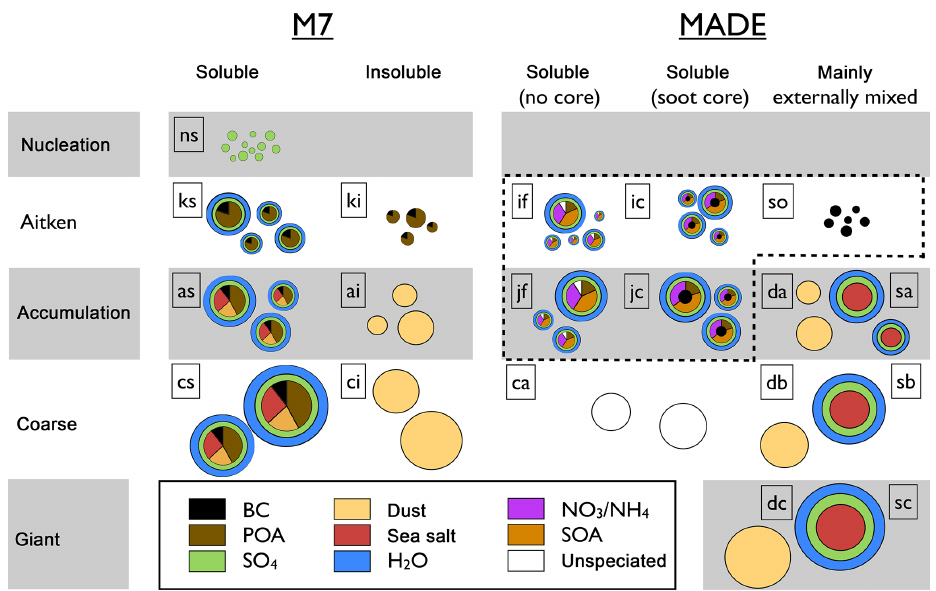
Figure 1. Comparison of chemical composition of aerosol modes for MADE and M7. The dashed line indicates modes that are considered for inter- and intra-modal coagulation in MADE. For M7, all modes participate in coagulation or intra-modal transfer by coagulation. The size and standard deviation of modes can be determined from Table 1 based on the two-letter abbreviations stated at the upper left of each mode (ns: M7 nucleation mode; ks: M7 solute-containing Aitken mode; ki: M7 insoluble Aitken mode; as: M7 solute-containing accumulation mode; ai: M7 insoluble accumulation mode; cs: M7 solute-containing coarse mode; ci: M7 insoluble coarse mode; if: MADE soluble Aitken mode without soot core; ic: MADE soluble Aitken mode with soot core; so: MADE pure soot mode; jf: MADE soluble accumulation mode without soot core; jc: MADE soluble accumulation mode with soot core; ca: MADE unspeciated anthropogenic coarse mode; da: MADE accumulation dust mode; db: MADE coarse dust mode; dc: MADE giant dust mode; sa: MADE accumulation sea salt mode; sb: MADE coarse sea salt mode; sc: MADE giant sea salt